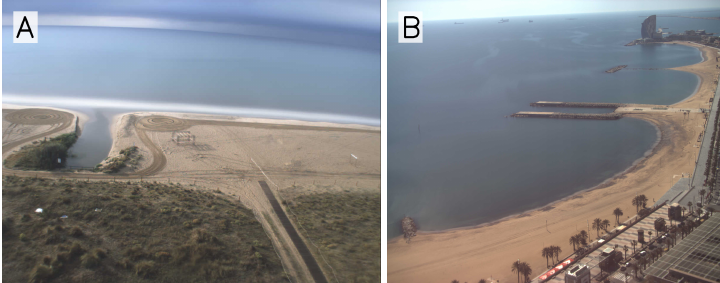
Figure 1. Images from Castelldefels ( A , at 41 ◦ 15 (cid:48) 54.9 (cid:48)(cid:48) N, 1 ◦ 59 (cid:48) 29.1 (cid:48)(cid:48) E) and Barcelona ( B , at 41 ◦ 23 (cid:48) 16.5 (cid:48)(cid:48) N, 2 ◦ 11 (cid:48) 50.9 (cid:48)(cid:48) E) video monitoring stations